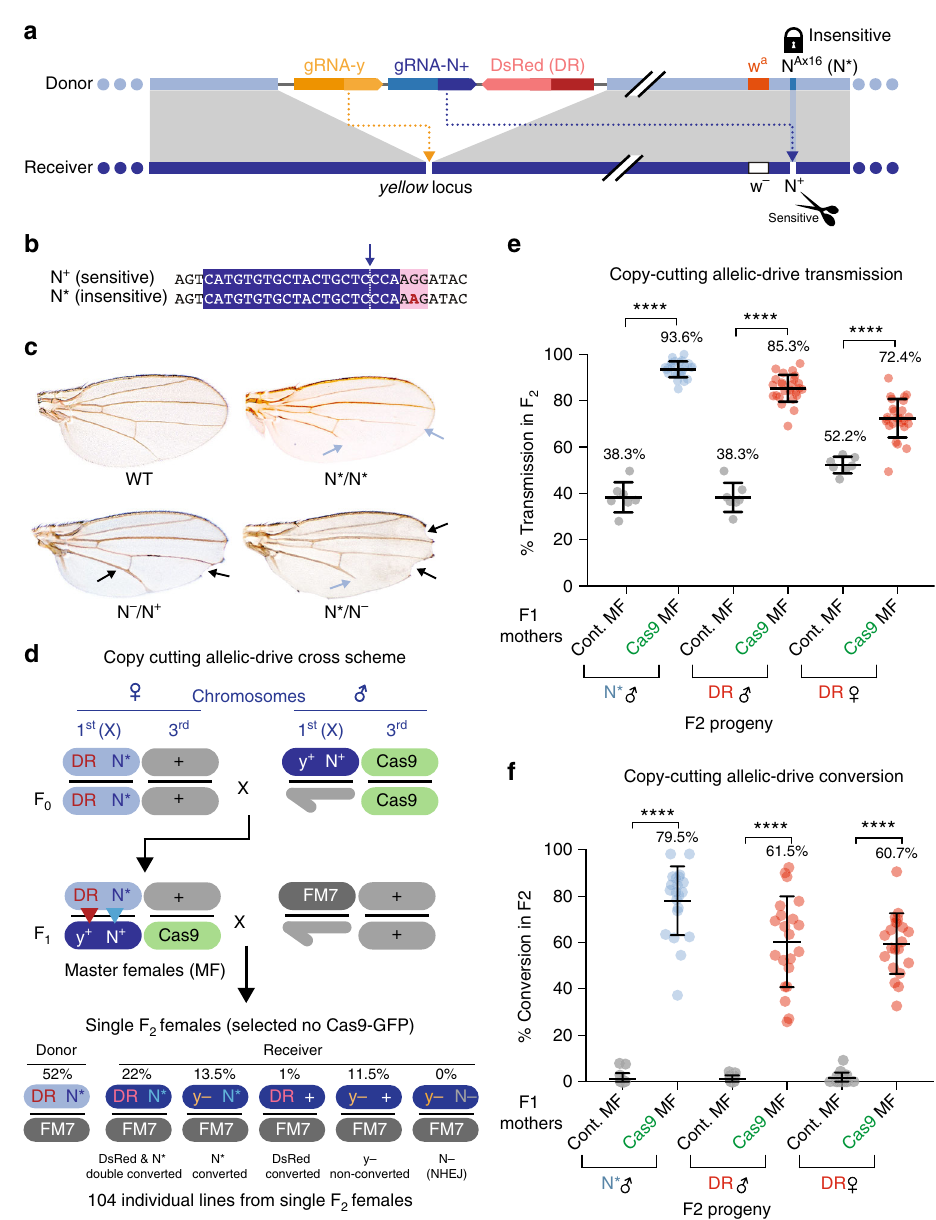
Fig. 1 Super-Mendelian inheritance of a dominant Notch allele in Drosophila . a Scheme depicting a DsRed-marked y <ccN> CopyCat element 7 that carries two gRNAs: (1) gRNA-y (yellow), which drives copying of the y <ccN> element at the yellow locus; and (2) gRNA-N + (blue), which directs cleavage of the sensitive (S) wild-type Notch allele N + S (scissors icon) to drive Super-Mendelian inheritance of the cleavage-insensitive (IS) N Ax16 allele ( N *, lock icon). Cas9 is provided in trans. b DNA sequence of the gRNA-N + target site on the sensitive wild-type Notch allele ( N + ), and the cleavage-insensitive N Ax16 allele ( N *) is highlighted in blue, and PAM site in pink. The critical G → A substitution conferring cleavage insensitivity in N Ax16 mutants is bold in red. The Cas9/gRNA cleavage site is indicated with a dashed line. c Wing phenotypes of wild-type (WT), N Ax16 homozygous ( N */ N *), N − loss-of-function heterozygous ( N − / N + ), and N Ax16 / N − heterozygous ( N * / N − ) Drosophila adults. d Crossing scheme used to generate F1 “ master females ” and genotype classes of 104 isogenic lines from single F2 females (detailed analysis in Table S2). X donor chromosome carrying the DsRed marked y <ccN> element (DR) and the N Ax16 ( N *) allele appears in light blue. WT ( ++ ) cut sensitive receiver chromosome is in dark blue. Third chromosome carrying a GFP-marked transgene expressing Cas9 ( vasaCas9 ) is depicted in green, and wild-type ( + ) chromosomes appear in light gray. The multiply inverted FM7 balancer chromosome is depicted in dark gray. Red and blue arrowheads indicate copying of the y <ccN> element and the N Ax16 allele, respectively. e Percentage of transmission of y <ccN> (DR, red circles) and N Ax16 allele ( N *, blue circles) in the presence or absence (gray circles) of Cas9. p Value intervals for this and all subsequent unpaired parametric t test analysis: **** p < 0.0001; *** p < 0.001; * p < 0.05. Bars denote mean value and standard deviation in this and all subsequent graphs. f Percentage conversion of receiver chromosomes in F2 progeny from F1 master females ( y <ccN> w a N Ax16 / ++ ; Cas9/ + ♀ X w − ♂ ). Eye color was used to distinguish progeny receiving donor ( w a = orange eyes) vs. receiver ( w − = white eyes) chromosomes